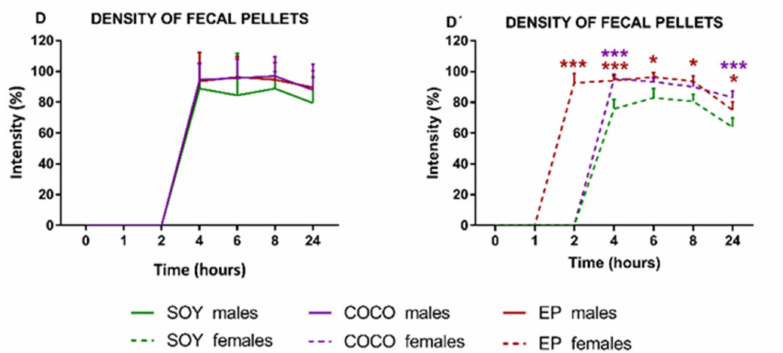
Figure 8. Effects of diet intervention on size and density of fecal pellets in the rat. Male ( A – D ) and female ( A’ – D’ ) rats were exposed to AIN-93G diet containing 7% of soybean oil (SOY), or to modified AIN-93G diet containing 3.5% of soybean oil supplemented with 3.5% of coconut oil (COCO) or with 3.5% of evening primrose oil (EP). Figures represent the number ( A , A’ ), size ( B , B’ ), diameter ( C , C’ ), and density ( D , D’ ) of fecal pellets based on X-rays obtained 0, 1, 2, 4, 6, 8, and 24 h after contrast administration. Data were analyzed in males and females separately. Data are presented as mean ± S.D. ( n = 6–12 animals per group). Two-way ANOVA followed by Bonferroni’s multiple comparison. * p < 0.05, ** p < 0.01 and *** p < 0.001 vs. SOY males or females.